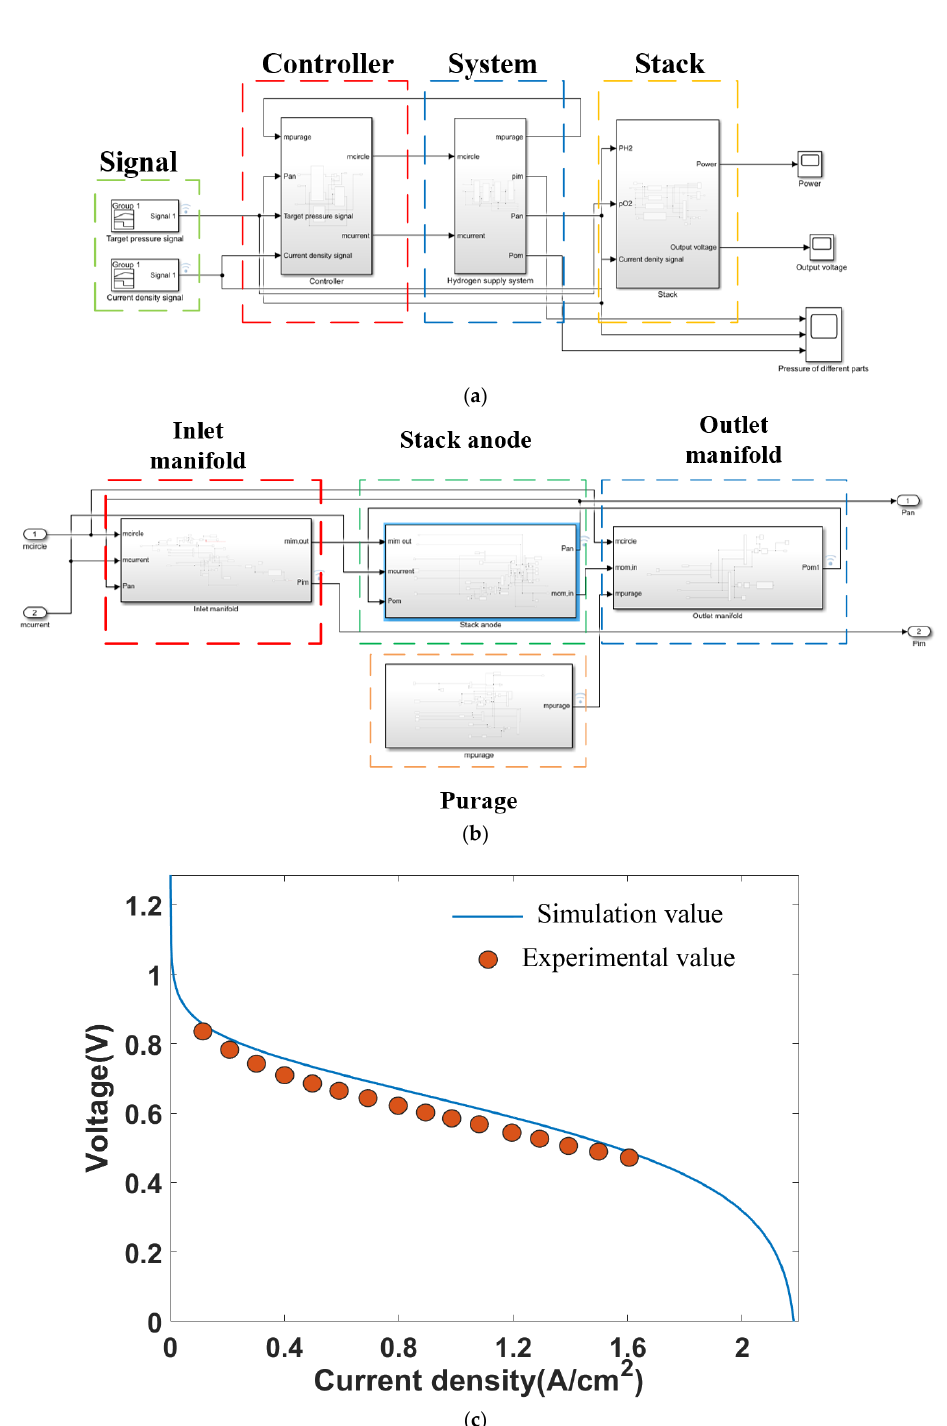
Figure 2. ( a ) The Simulink model of the hydrogen system. ( b ) The Simulink model of the hydrogen supply pressure model. ( c ) The comparison of simulation and experimental performance.